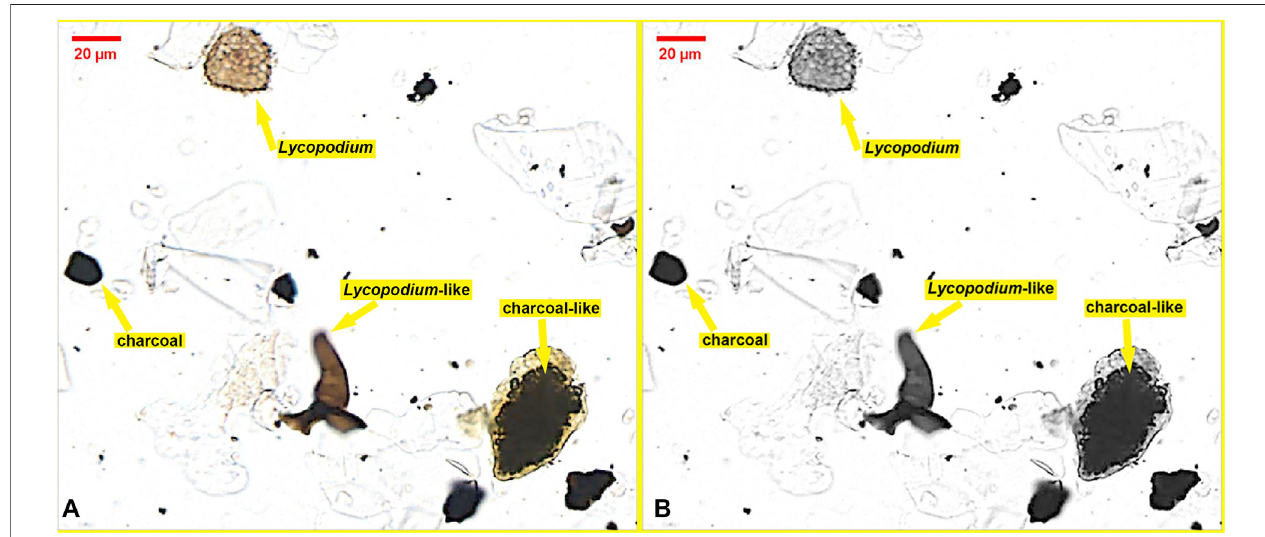
FIGURE 2 | Spectral and morphological characteristics of microcharcoal, microcharcoal-like, Lycopodium spores, and Lycopodium -like objects in a RGB color model (A) andgrayscaleimage (B) . Lycopodium -likemeansthatitsspectralsignatureissimilarto Lycopodium whenclassi fi edbycomputer,althoughtheycanbeeasily distinguished